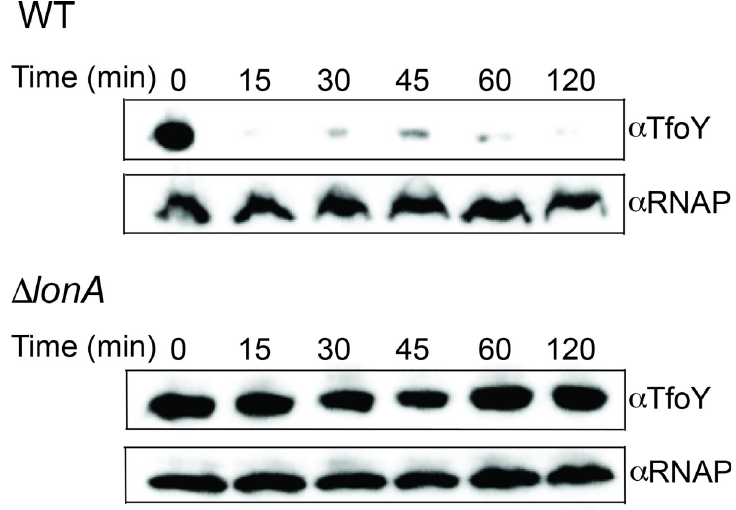
Fig 2. TfoY stability depends on the LonA protease. In vivo stability of TfoY after translational inhibition. TfoY was overproduced from the Tn7 locus in WT and a Δ lonA strain. Stability of TfoY was analyzed by western blot using an antibody against TfoY 1-hour post translational inhibition via chloramphenicol. RNAP was used as a biomass loading control.